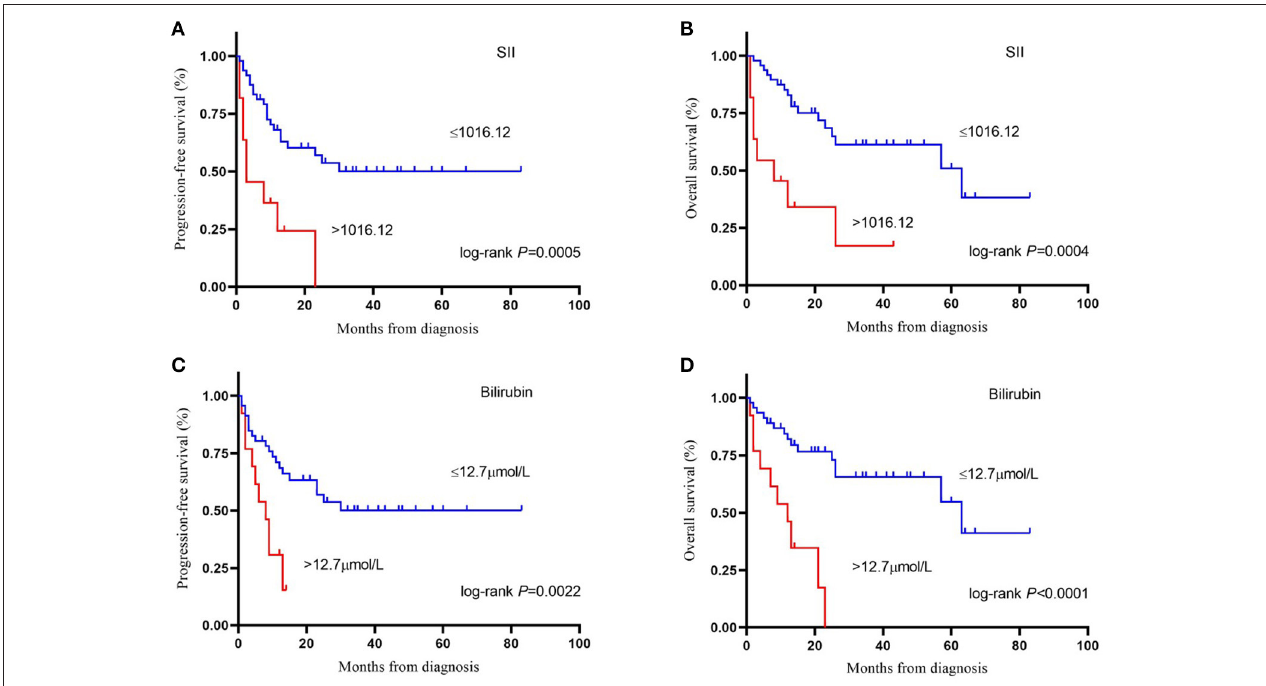
FIGURE 1 | Kaplan-Meier survival curve of progression–free survival (A) and overall survival (B) by systemic immune-inflammation index (cut-off = 1,016.12). Kaplan-Meier survival curve of progression–free survival (C) and overall survival (D) by bilirubin (cut-off = 12.7 µ mol/L). SII, systemic immune-inflammation